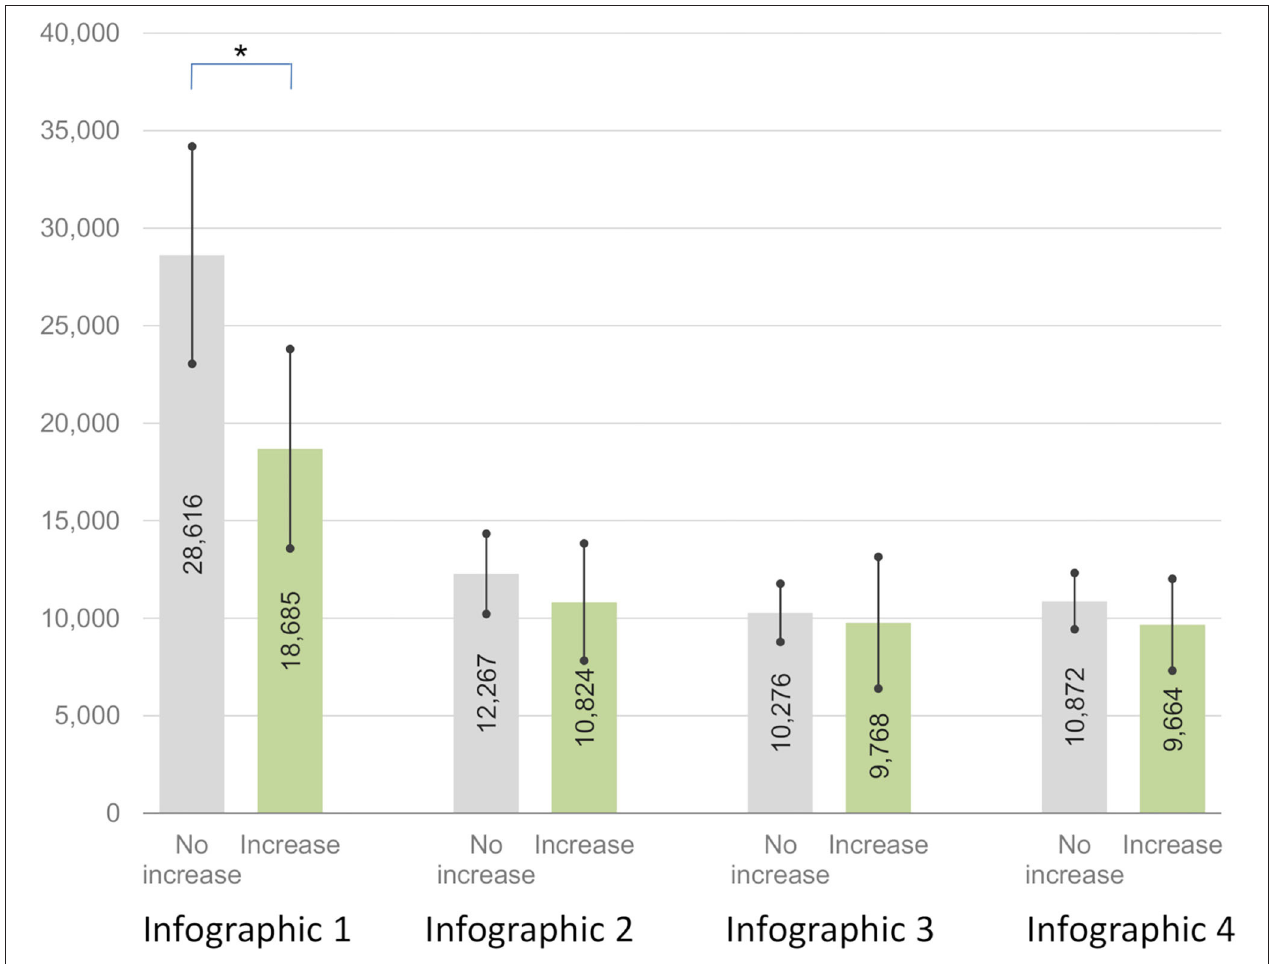
FIGURE 5 | Dwell time of visual attention on negatives in infographics 1–4 for groups with no increase and increase in debt literacy as an effect of debt education ab . a Mean dwell time in milliseconds. Significance: * p < 0.05. b Error bars represents 95.0% Lower and Upper CL for Mean.